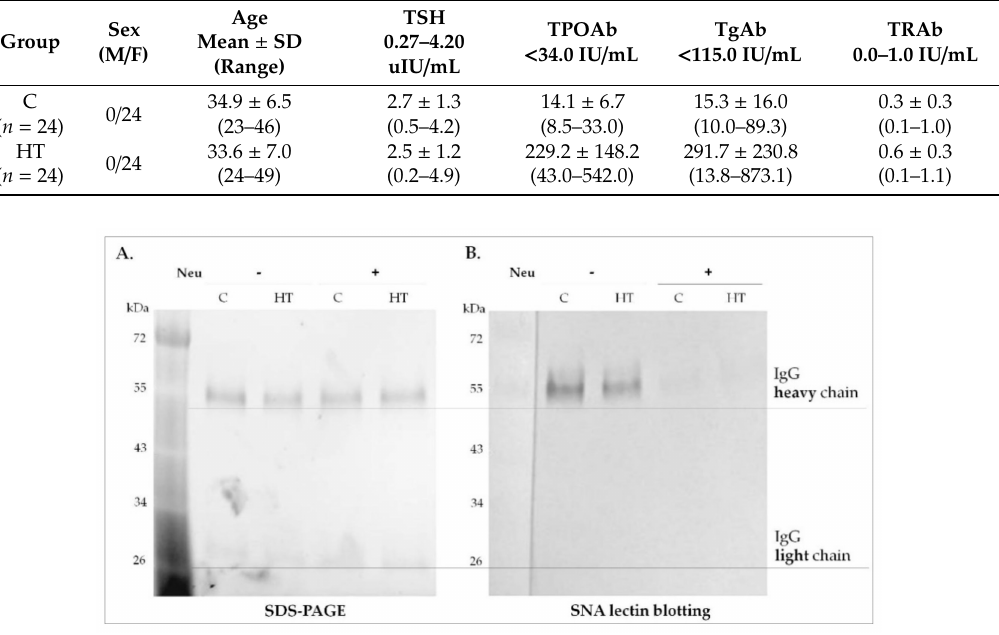
Figure 3. The e ffi ciency of IgG desialylation. IgG samples from healthy donors (C, control) and Hashimoto’s thyroiditis (HT) patients after Neu treatment ( + ) and untreated ( − ) were resolved by SDS-PAGE in reducing conditions ( A ) and probed with Sambucus nigra agglutinin (SNA)-specific α 2,6-linked sialic acid ( B ). Molecular mass of IgG heavy and light chains was verified using a PageRuler Prestained Protein Ladder (Thermo